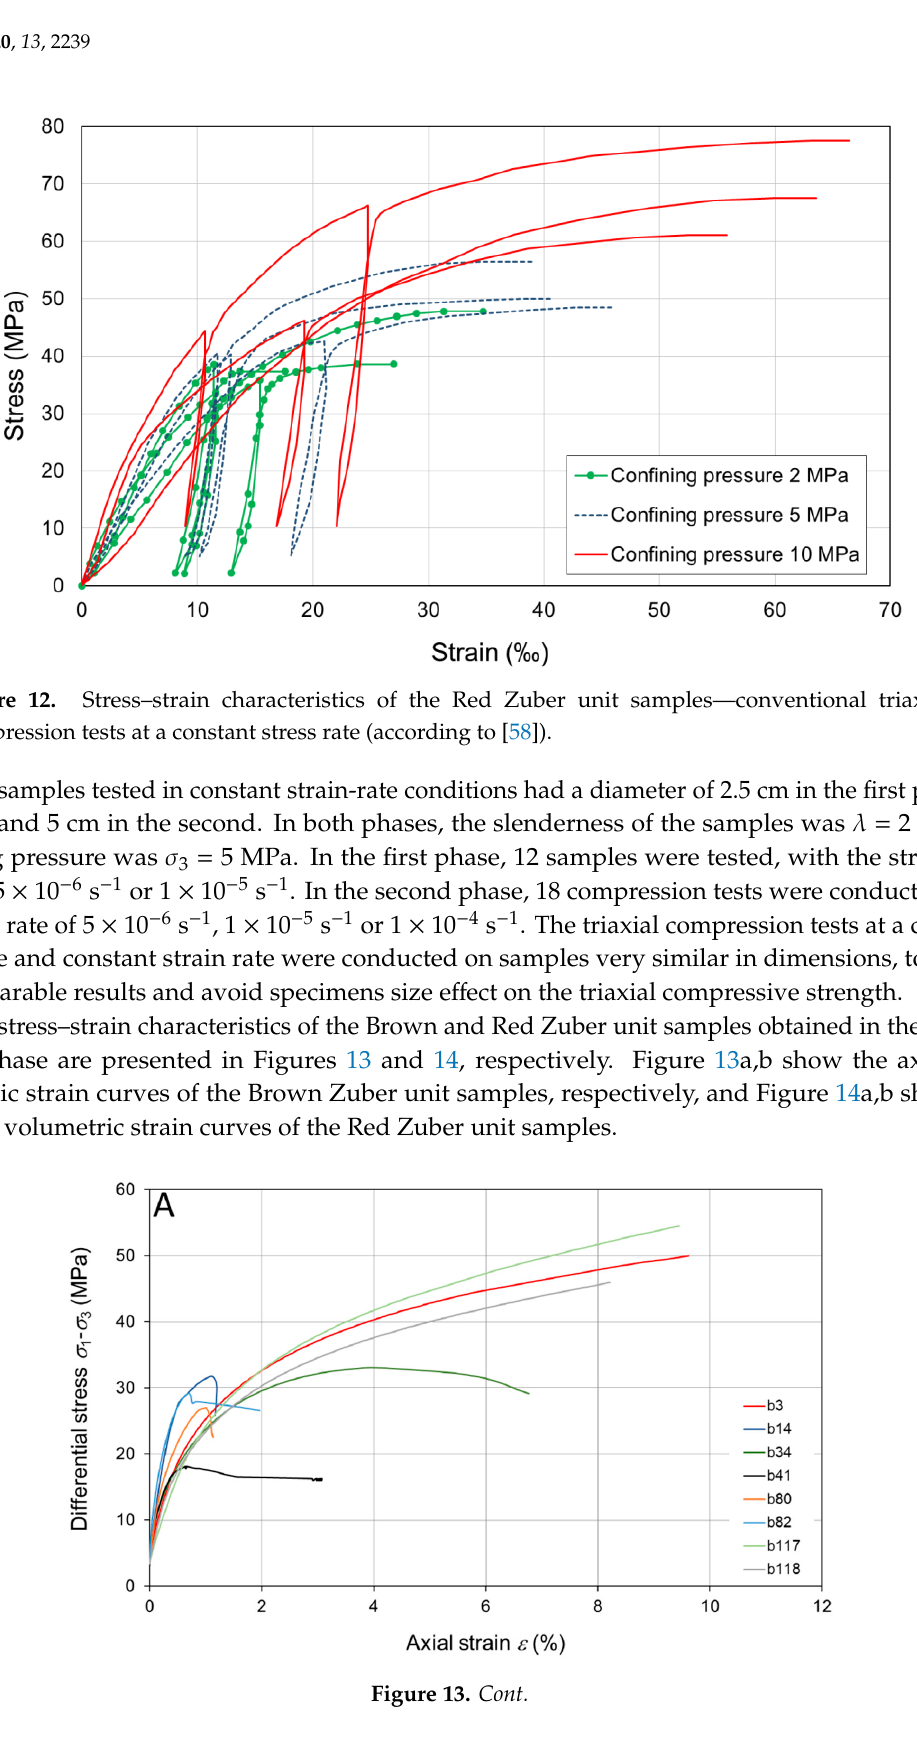
Figure 13. Stress–strain characteristics of the Brown Zuber unit samples in the tests at a constant strain rate. ( A )—axial strain; ( B )—volumetric strain (according to [57]).